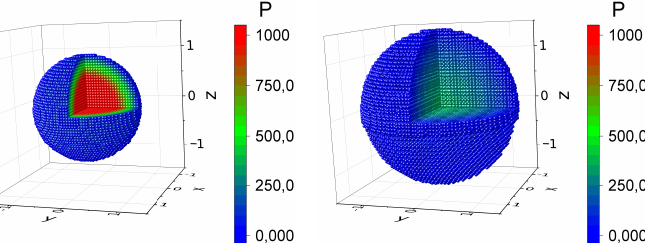
Figure 5. The 3D distribution of gas SPH particles with ε = 0.8 and short relaxation time t stop = 0.001 (model S) at two time moments t = 0 and t = 0.25.